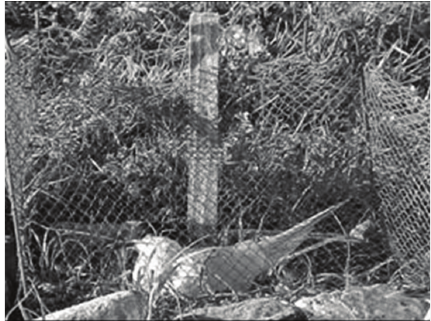
Figure 2: Individual fence around the nests of Sterna